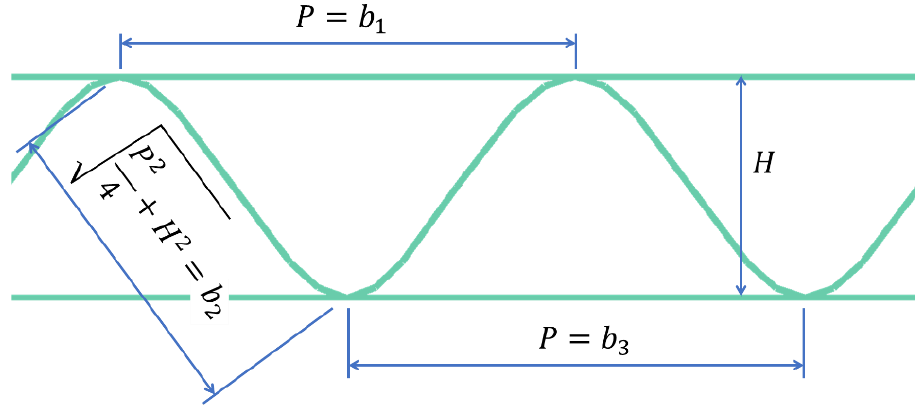
Figure 4. Cross-section of three-layer corrugated